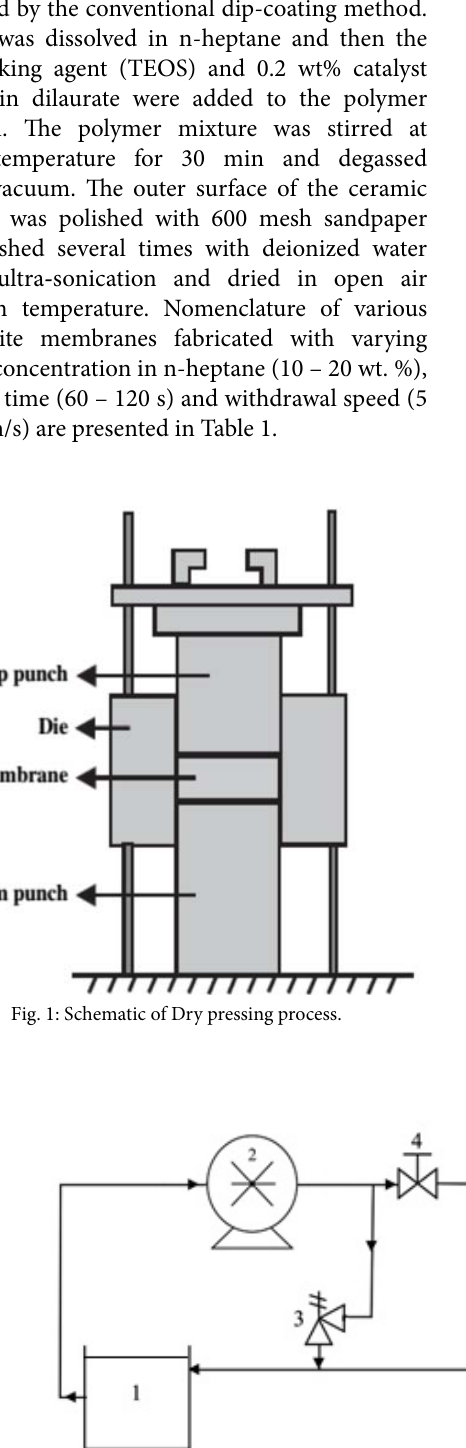
Fig. 2: Schematic diagram of membrane modal apparatus for membrane performance tests: (1) feed tank, (2) pump, (3) Pressure valve, (4) valves, (5) Pressure gauge, (6) membrane module, (7) permeate